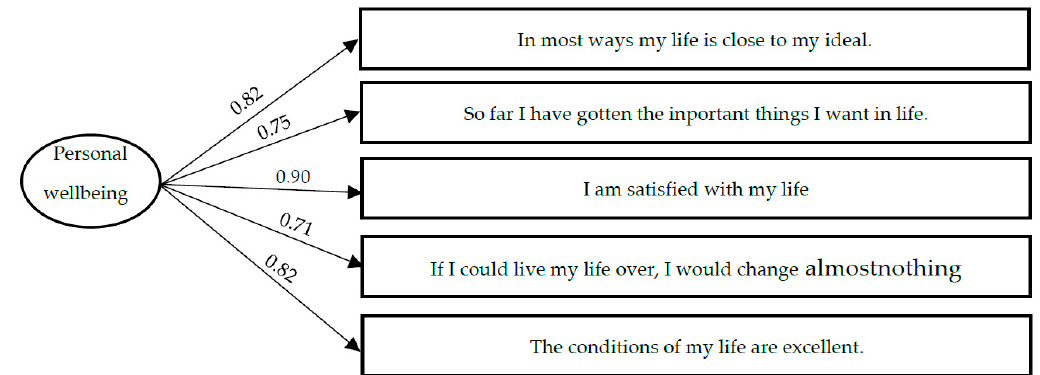
Figure 1. Measurement model of the Subjective Personal Wellbeing scale.